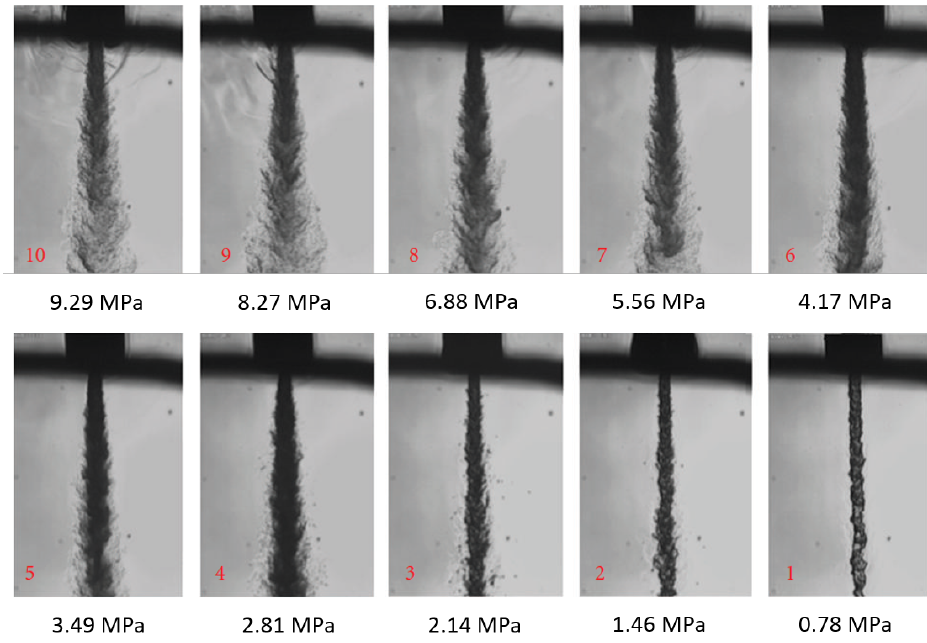
Figure 1. Injection of cryogenic nitrogen into gaseous nitrogen at various supercritical and subcritical pressures by Chehroudi